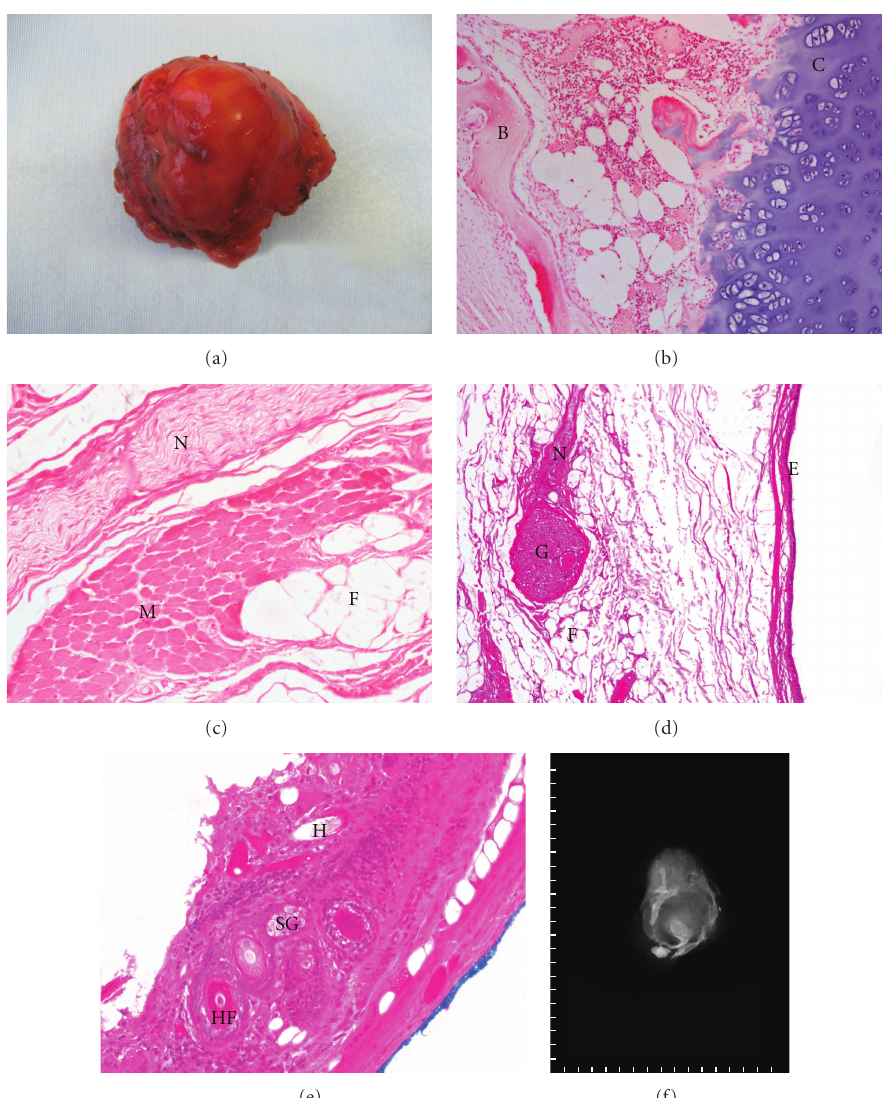
Figure 5: Solid component of mass stained with haematoxalin and eosin. (a) Macroscopic appearance of fresh unfixed specimen. (b) Microscopy x10 magnification. Osteoblast layer on the surface of bone (B) adjacent to cartilage (C). (c) Microscopy x20 magnification. Skeletal muscle fibres (M), nerve (N), and fat (F). (d) Microscopy x10 magnification. Nerve cells (N), ganglion (G), fat (F) and, epithelia lined cyst (E). (e) Microscopy x20 magnification. Pilosebaceous unit comprising of sebaceous gland (SG), hair follicle (HF), hair (H). (f) Plain X-ray of solid component showing skeletal